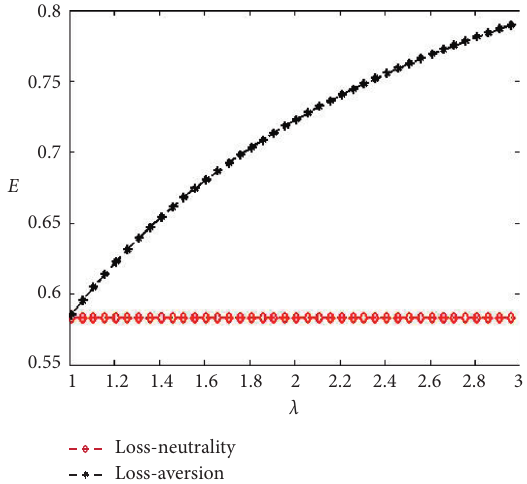
Figure 11: Effect of λ on environment ( N � 2 and R � 1).